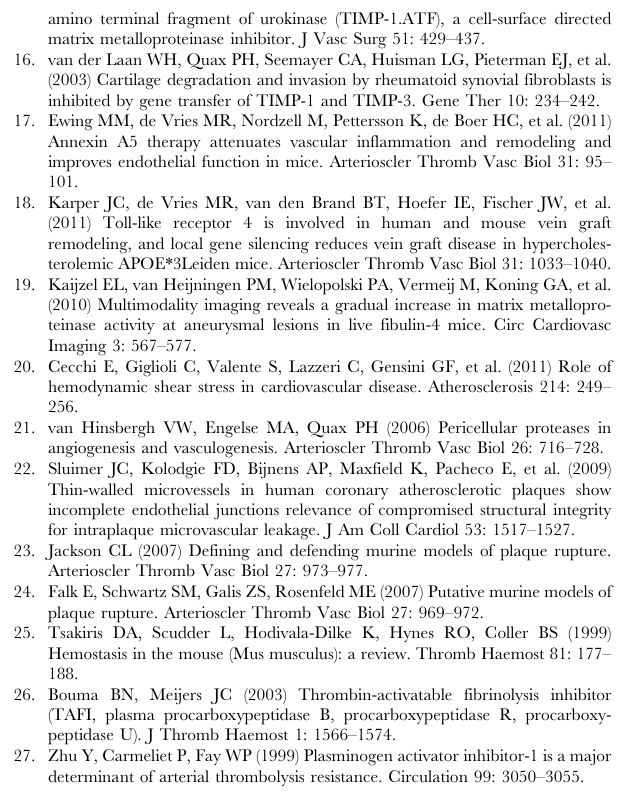
Figure S2 Neovessels are present in vein graft lesions.